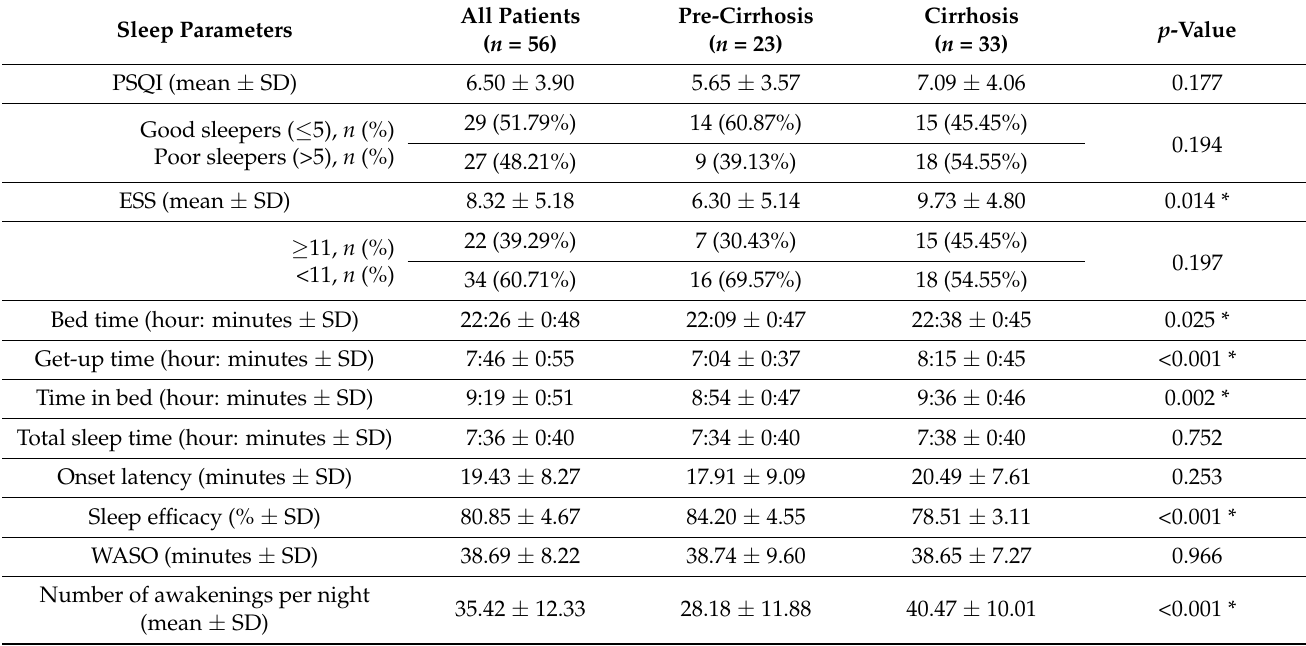
Table 2. Sleep assessment among patients with CLDs.